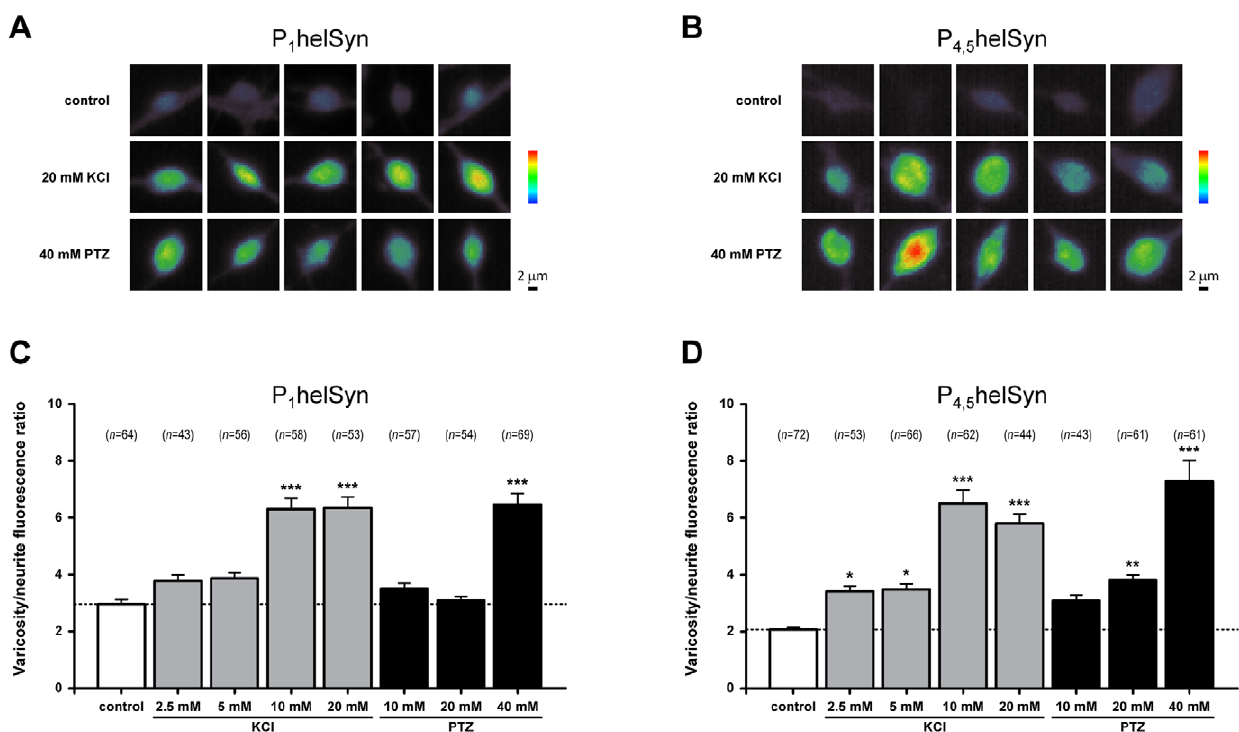
Figure 8. PTZ-application promotes phosphorylation of synapsin domain A and B in a dose-dependent fashion. (A,B) Representative acquisitions of B2 varicosities expressed in pseudocolour, from purple (scarcely stained) via green (weakly stained) to red (most strongly stained), to better appreciate differences in synapsin phosphorylation. Treatments with 20 mM KCL and 40 mM PTZ were shown. Scale bars: 2 m m. (C,D) Quantification of synapsin phospho-levels from varicosities of B2 neurons processed with the indicated treatments and immunolabelled with either a -P 1 helSyn or a -P 4,5 helSyn antibodies. A ratio between the intensities of varicosity and its proximal neurite has been calculated. The corresponding number of examined varicosities ( n ) is indicated on each